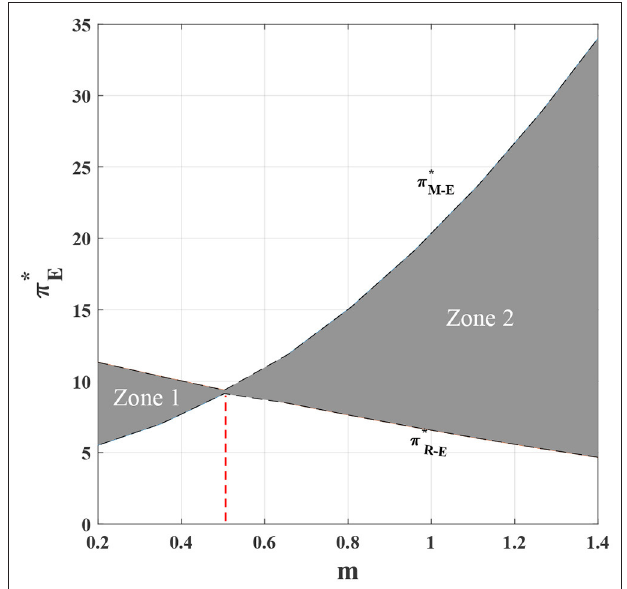
FIGURE 3 | The impact of m on the channel profits under the decentralized cases.